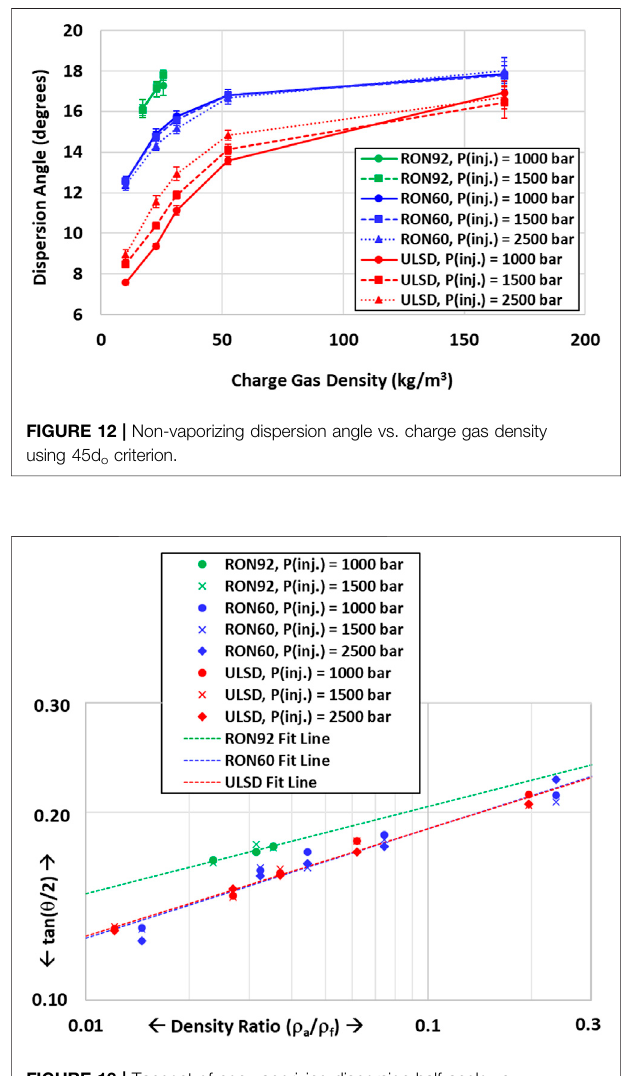
Figure 13 . The RON92 results fall on a different fi t line which